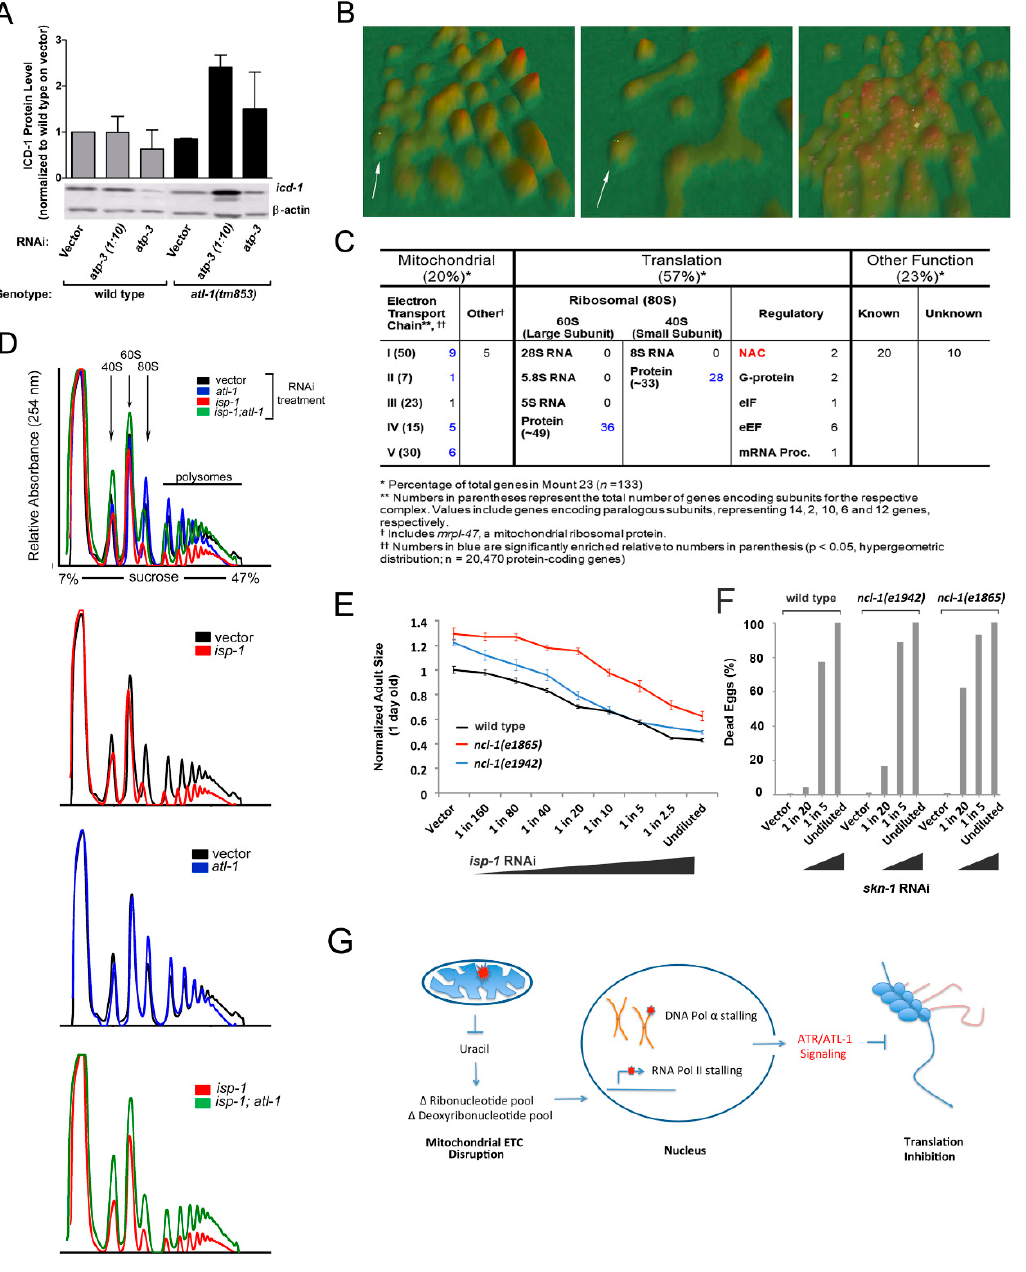
Figure 8. Knockdown of atl-1 prevents global translation reduction caused by mitochondrial ETC disruption. ( A ) Top panel: ICD-1 protein abundance in atl-1(tm853) mutants relative to wild type animals following atp-3 knockdown (N = 2, bars indicate range ). Bottom panel : Representative west- ern blot. All worms are the unbalanced F1 progeny of parents carrying the nT1 reciprocal chromo- somal translocation. ( B ) C . elegans gene co-expression terrain map generated using VxInsight [66] showing icd-1- containing ‘Mount 23’ (white arrow) . Progressive zoom shots of Mount 23 are shown ( left to right ). The position of icd-1 is marked by a white square . ( C ) 88 of 133 (66%) genes comprising Mount 23 of the C . elegans gene co-expression terrain map encode either mitochondrial ETC proteins or ribosomal proteins, including both α - and β -NAC (ICD-1). ( D ) Polysome profiling shows knock- down of atl-1 (9/10th RNAi strength) restores the level of actively-translating ribosomes to control levels in worms grown on isp-1 RNAi (1/10th strength). ( E ) ncl-1(e1865) and ncl-1(e1942) mutants do not confer resistance to the size-reducing effects of bacterial feeding RNAi targeting isp-1 relative to wild type (N2) worms. ncl-1 mutants are naturally larger that N2 worms. (mean +/ − SEM). ( F ) RNAi